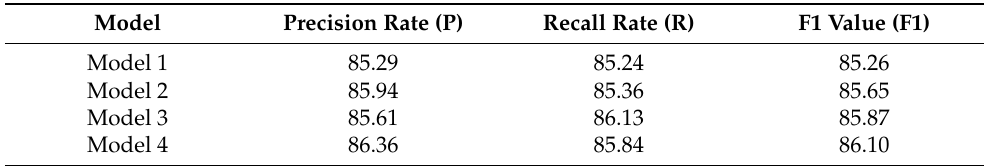
Table 4. Experimental hyperparameter settings (unit: